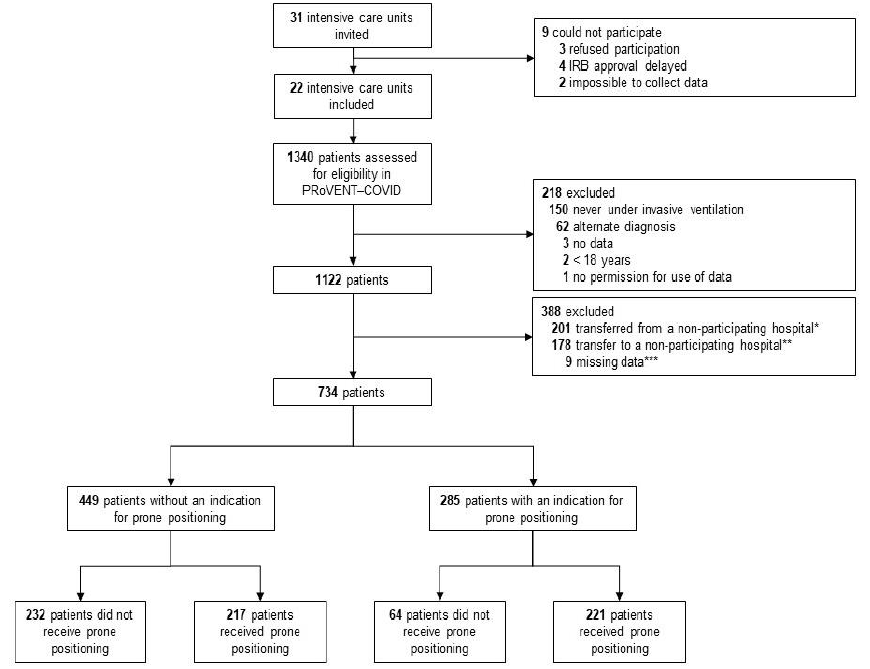
Figure 1. Flow chart of patient inclusion.